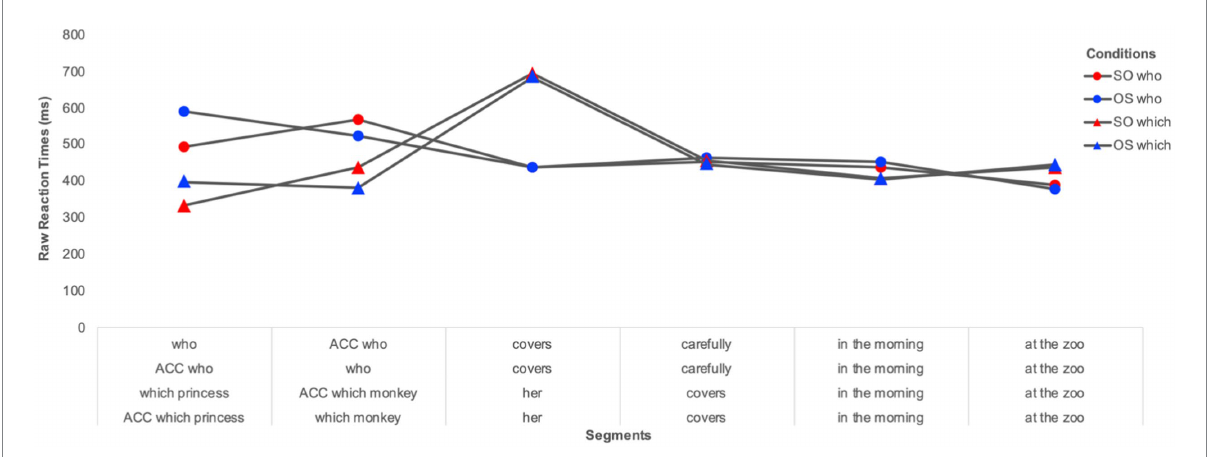
FIGURE 2 Segment-by-segment distribution of residual RTs per wh-type ( who vs. which ) and per wh-order (SO vs. OS) for Romanian-speaking monolingual children.